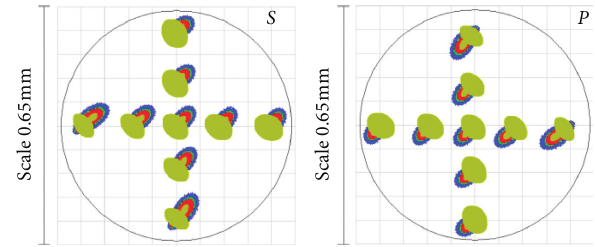
Figure 5: Theoretical spot diagram. The 555nm spectral channel for ( o ) ( S ) and ( e ) ( P ) light components.